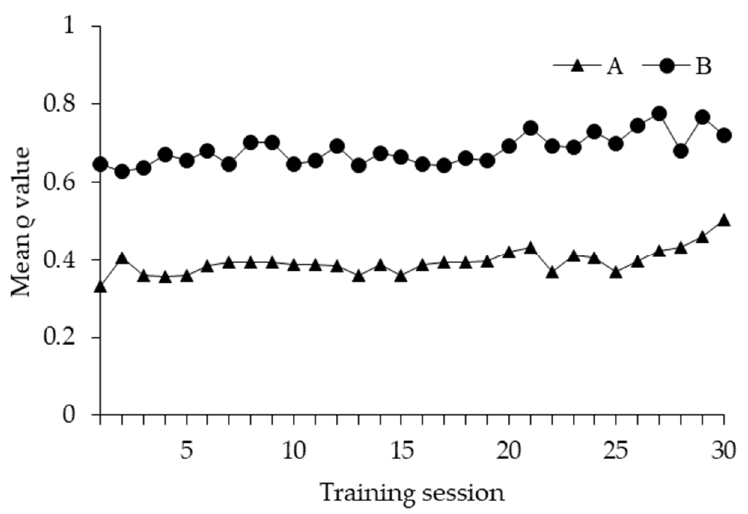
Figure 5. Learning performance, indicated as mean ρ values of both species (N = 12), across training sessions for each